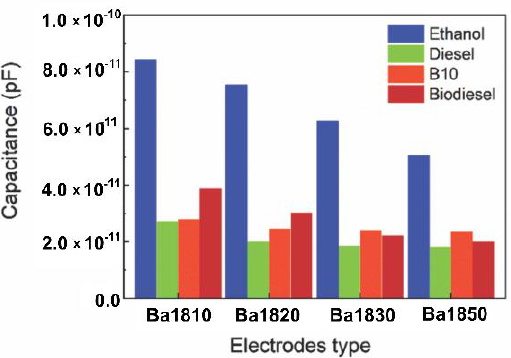
Figure 10. Response of different microelectrode geometries for fuel samples at 1000 Hz and 0.2 V. Also, the electrodes showed a greater response to ethanol compared to other